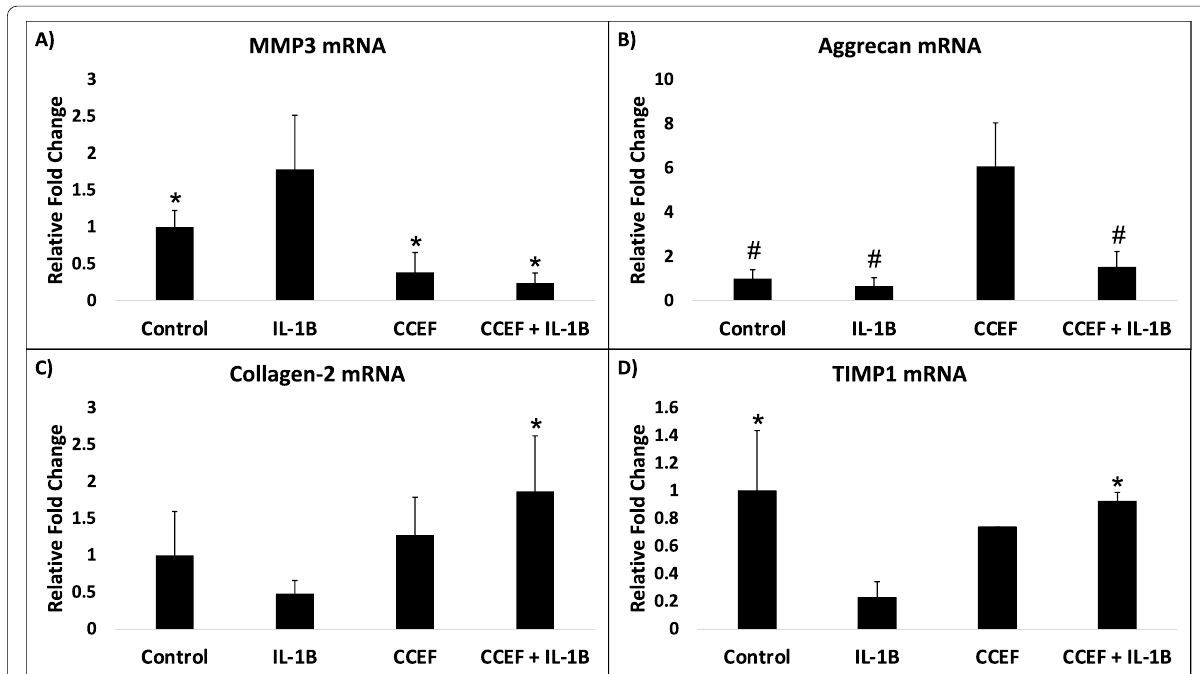
Fig. 3 Gene Expression of Bovine Articular Cartilage Explants. Effect of CCEF stimulation of bovine articular cartilage explants in the absence or presence of IL‑1B for one day on gene expression of A MMP3, B Aggrecan, C Collagen‑2, and D TIMP1. A statistically significant difference from the IL‑1B treatment group is denoted by an asterisk (*). A statistically significant difference from the CCEF treatment group is denoted by a (#)